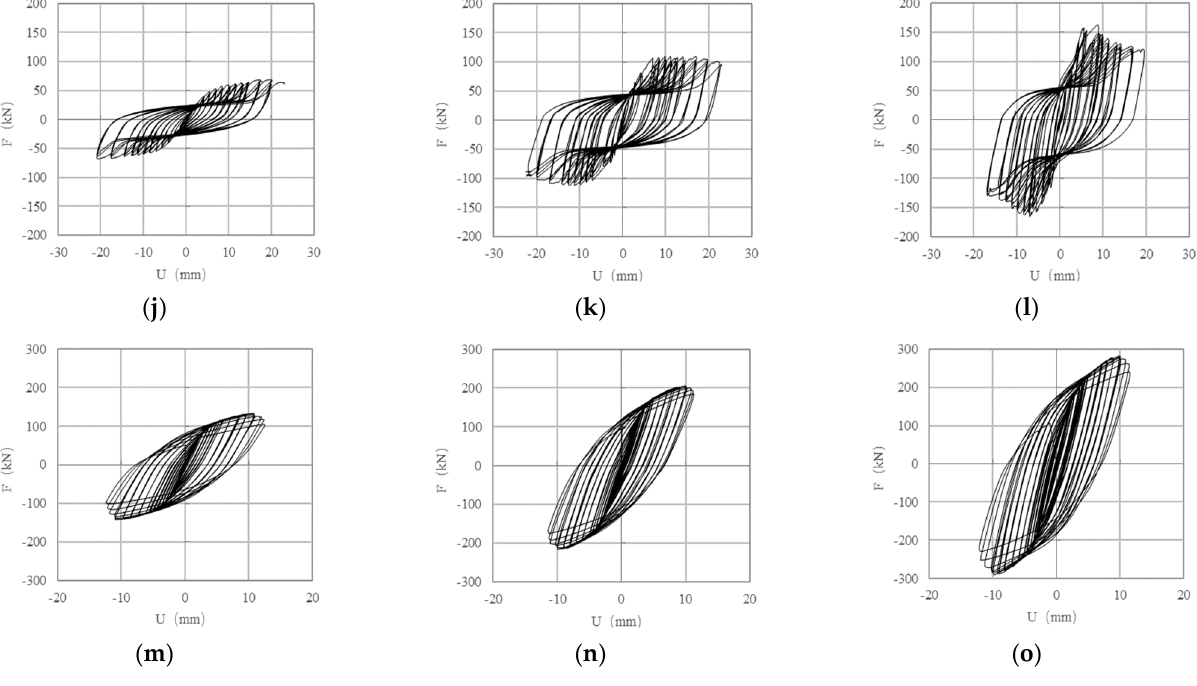
Figure 9. Hysteresis curves of the specimens. ( a ) 150 − A1, ( b ) 150 − A2, ( c ) 150 − A3, ( d ) 150 − B1, ( e ) 150 − B2, ( f ) 150 − B3, ( g ) 150 − C1, ( h ) 150 − C2, ( i ) 150 − C3, ( j ) 150 − D1, ( k ) 150 − D2, ( l ) 150 − D3, ( m ) 200 − A1, ( n ) 200 − A2, ( o ) 200 − A3.